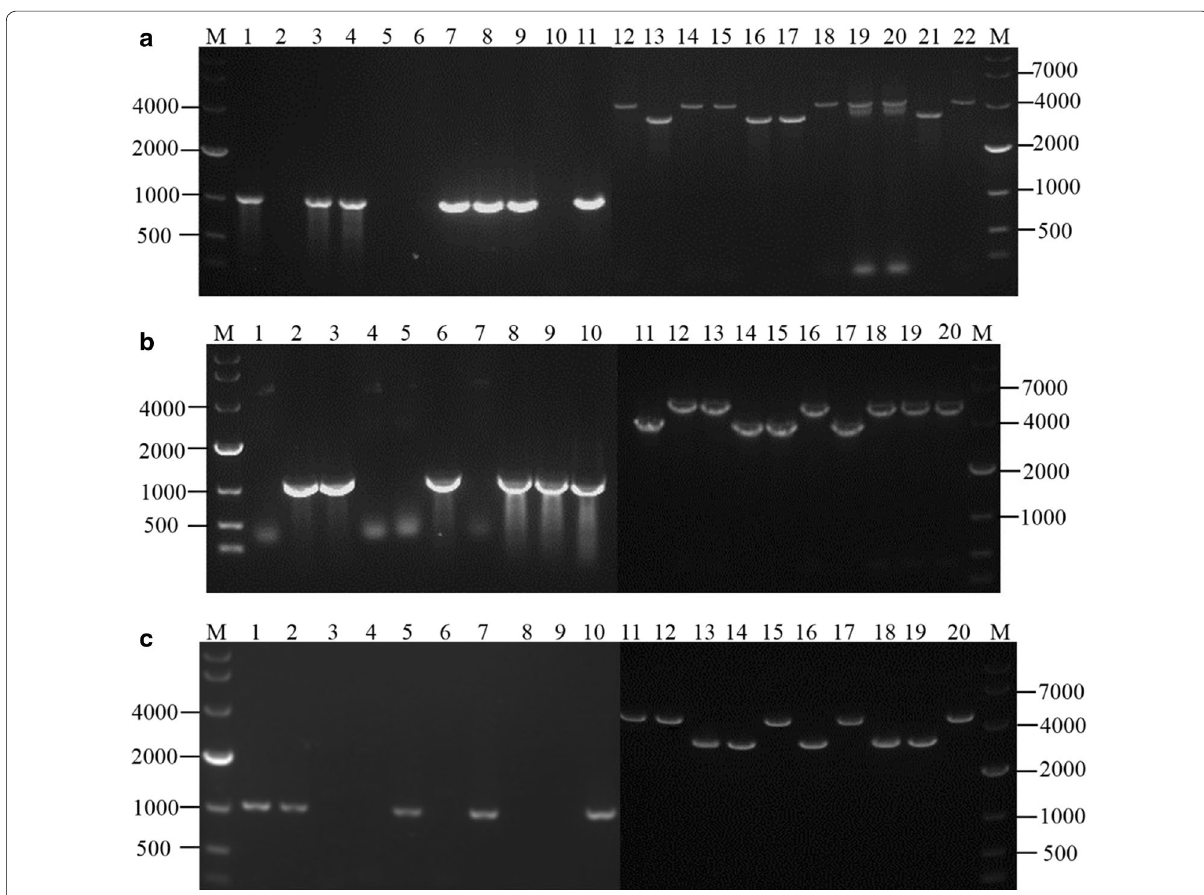
Fig. 2 Agar gel analysis. a Verification of tri3 deletion. Numbers from 1 to 10 and 12 to 21 refer to the arbitrarily chosen transformants. Numbers 11 and 22 refer to the wild strain. The numbers and their corresponding transformants are as follows: 1 and 12, Δ tri3 -1; 2 and 13, Δ tri3 -2; 3 and 14, Δ tri3 - 3; 4 and 15, Δ tri3 -4; 5 and 16, Δ tri3 -5; 6 and 17, Δ tri3 -6; 7 and 18, Δ tri3 -7; 8 and 19, Δ tri3 -8; 9 and 20, Δ tri3 -9; and 10 and 21, Δ tri3 -10. Lanes 2, 5, 6, and more, Δ tri3 -2, Δ tri3 -5, Δ tri3 -6, and Δ tri3 -10 (lanes 13, 16, 17, and 21, respectively) showed the expected band of 3.6 kb (reduced by